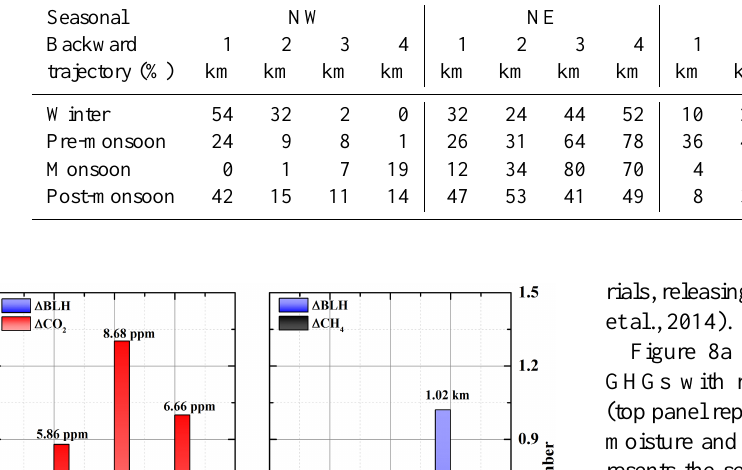
Table 4. Cluster analysis of air mass trajectories reaching Shadnagar at various heights during different seasons. Seasonal